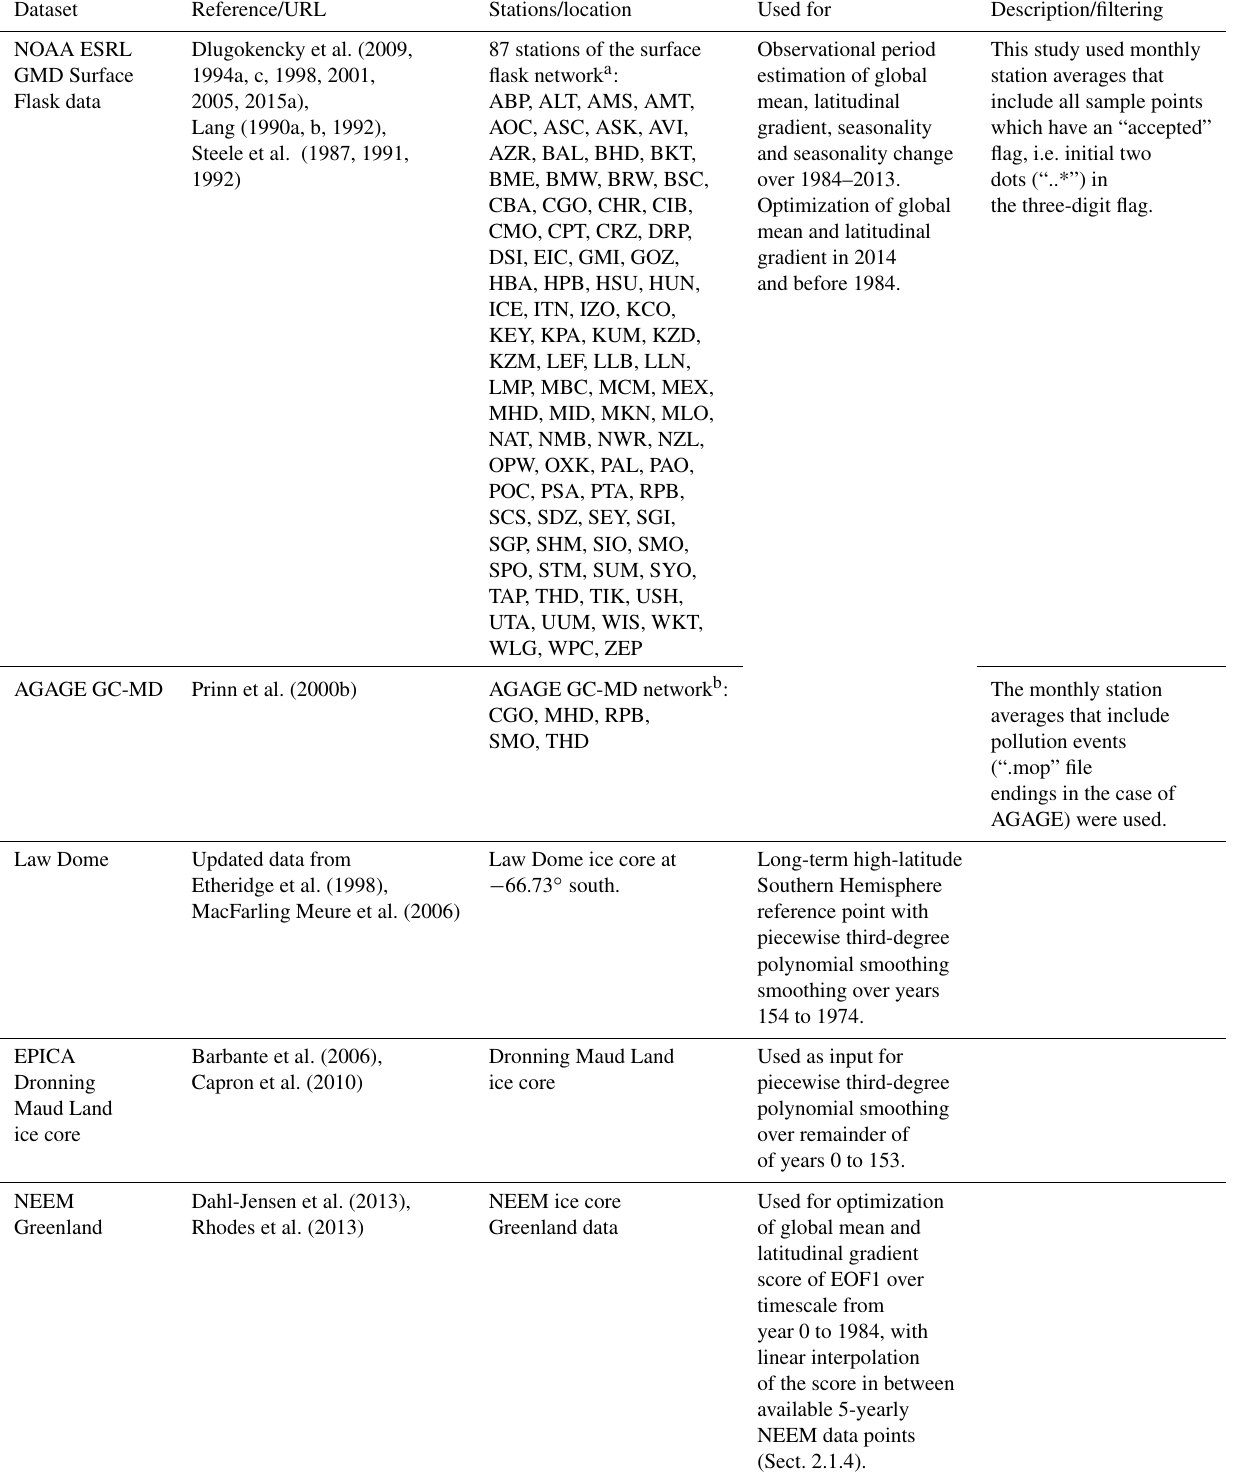
Table 3. Raw data used for CH 4 surface concentration field